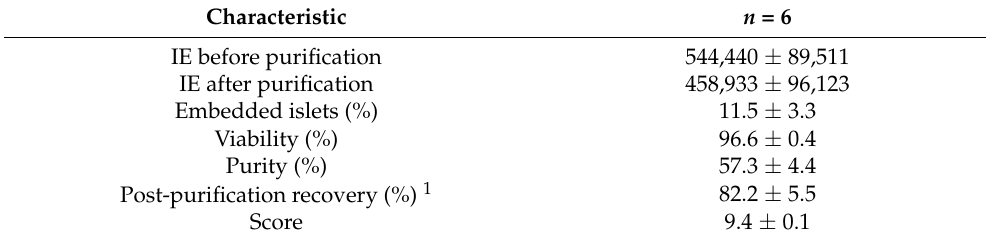
Table 2. The islet